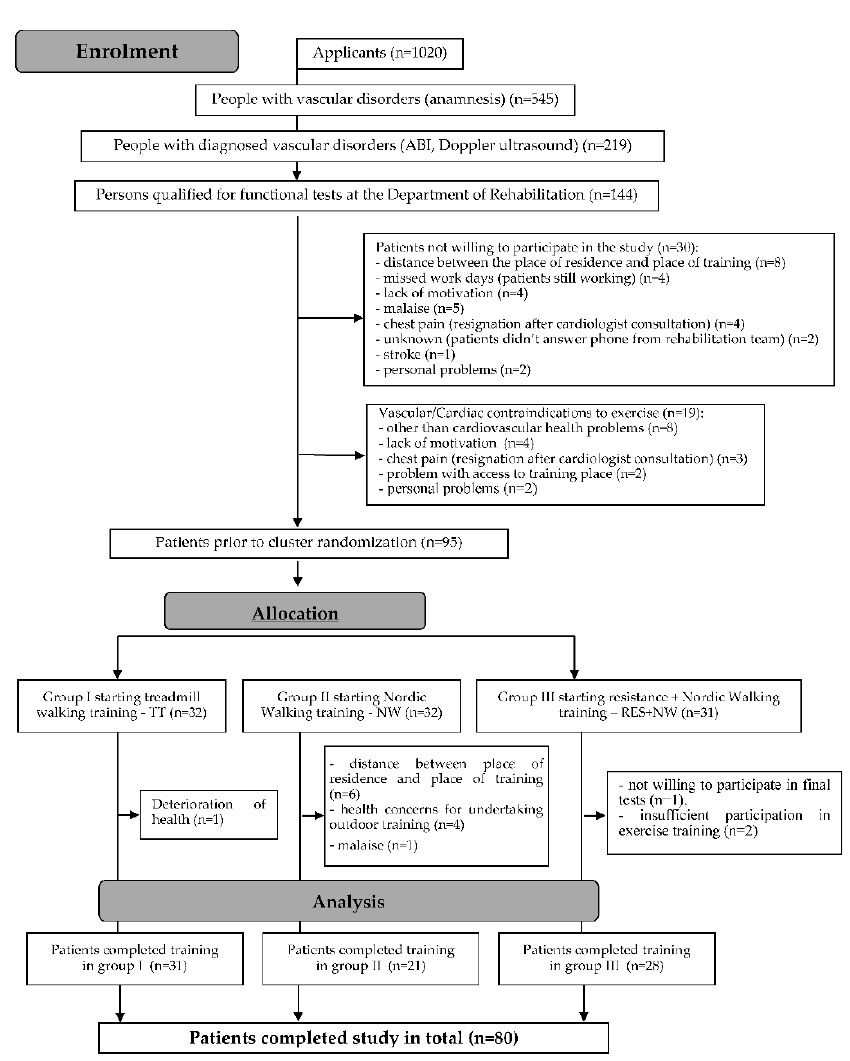
Figure 1. A detailed process of patient recruitment for the rehabilitation program — with the consent of the authors of Kropielnicka et al.